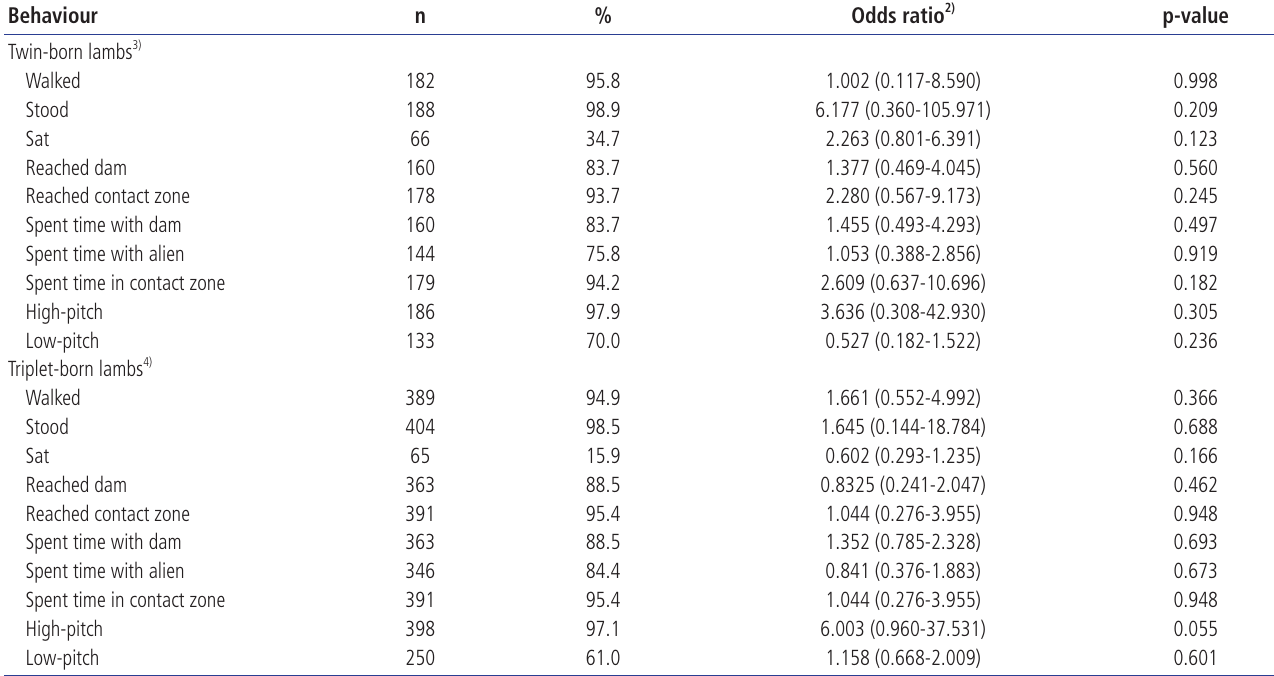
Table 4. Behaviours expressed by twin and triplet lamb during the maternal recognition test 1)